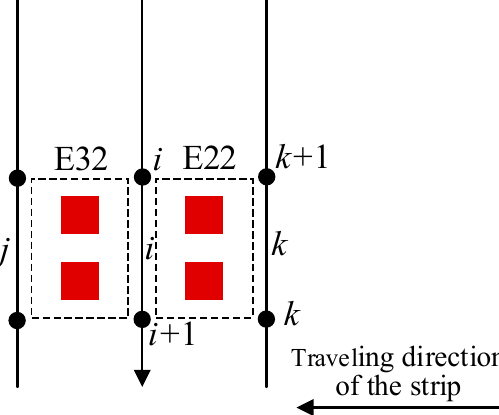
Figure 2. The i th strip element and enclosed calculation zones on both sides.